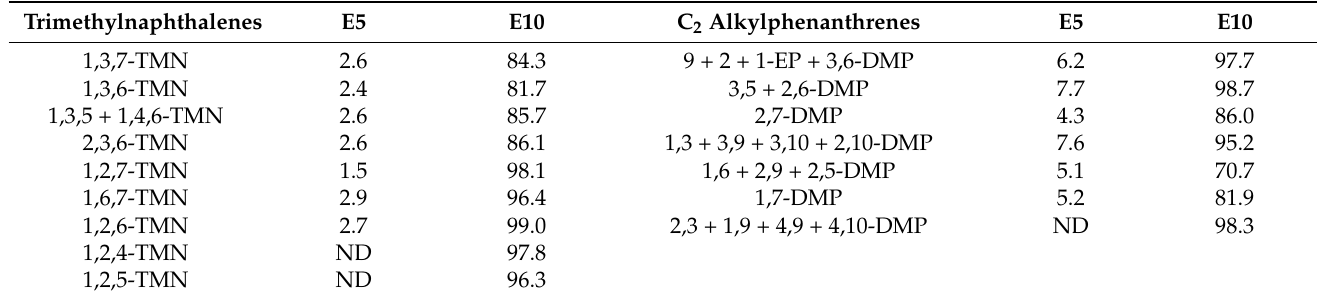
Table 1. The amount of trimethylnaphthalenes and C 2 alkylphenanthrenes eluted by 5%